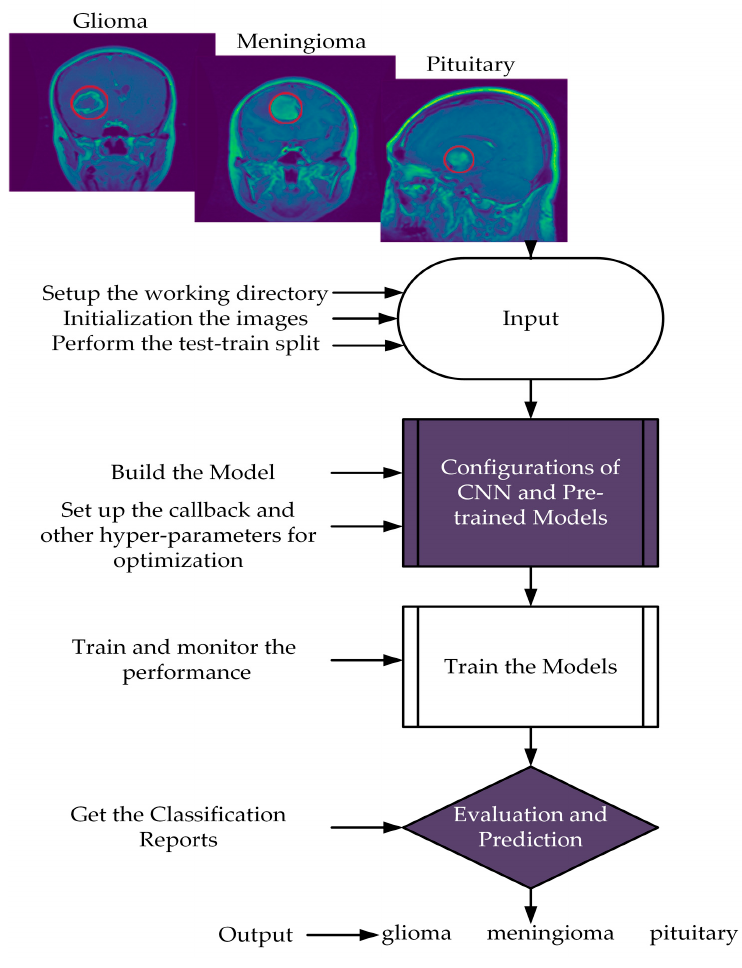
Figure 1. Flow chart of the proposed scheme.